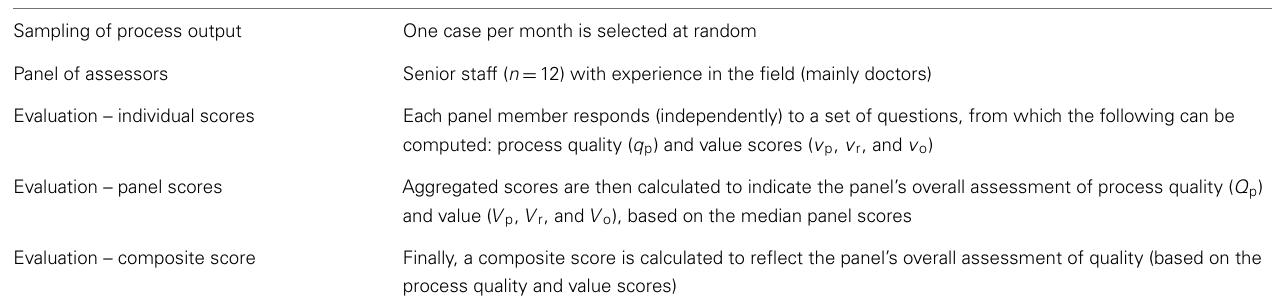
Table 1 | Main features of the quality-assessment scheme